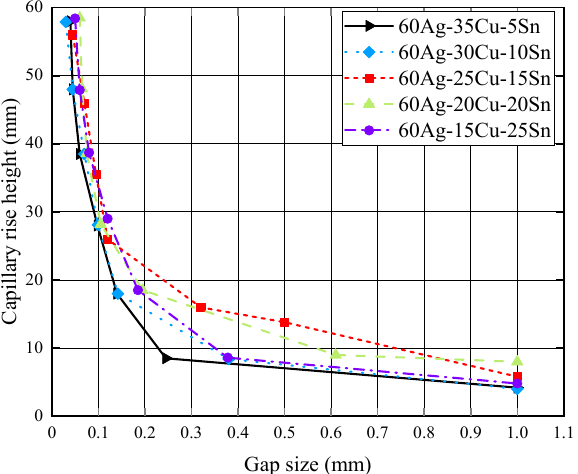
Figure 2. Capillary rise heights of Ag60Cu-xSn brazing filler metals in gaps with different widths [15].